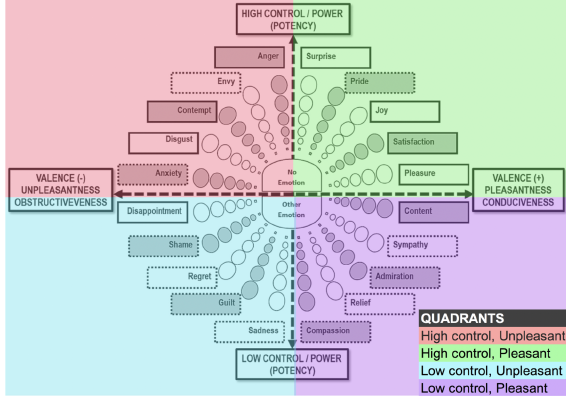
Fig. 1 . Adapted illustration of the GEW and the four emotional